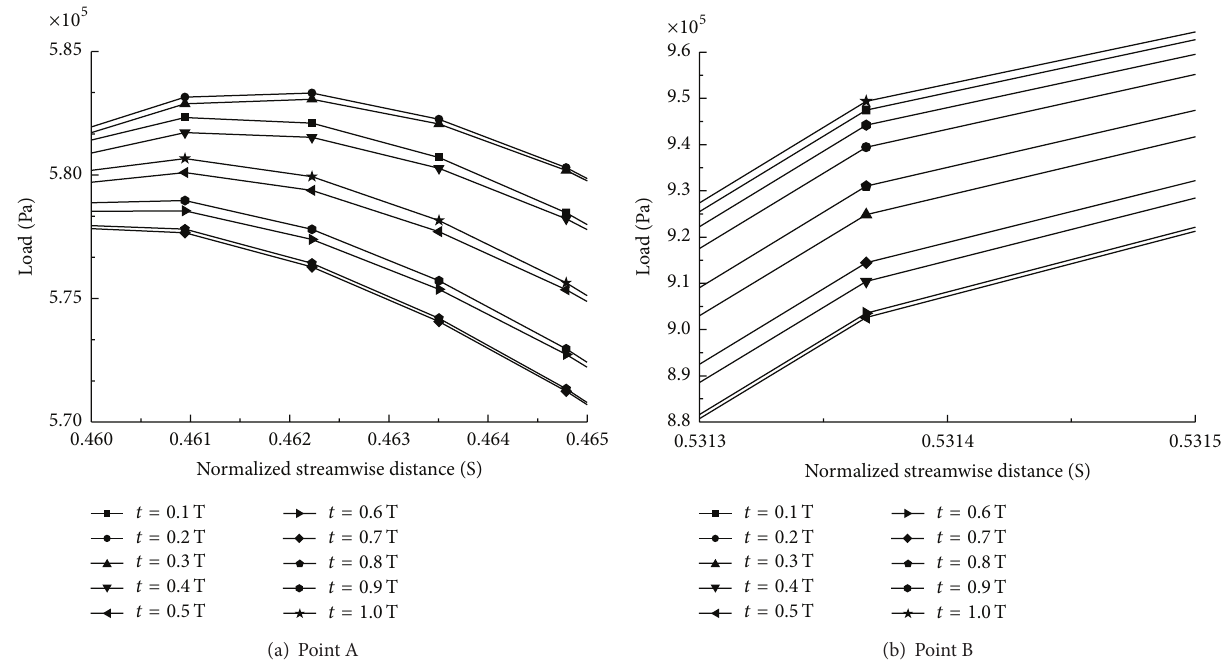
Figure 14: Partial enlarged drawing of pressure distributions along stationary engine